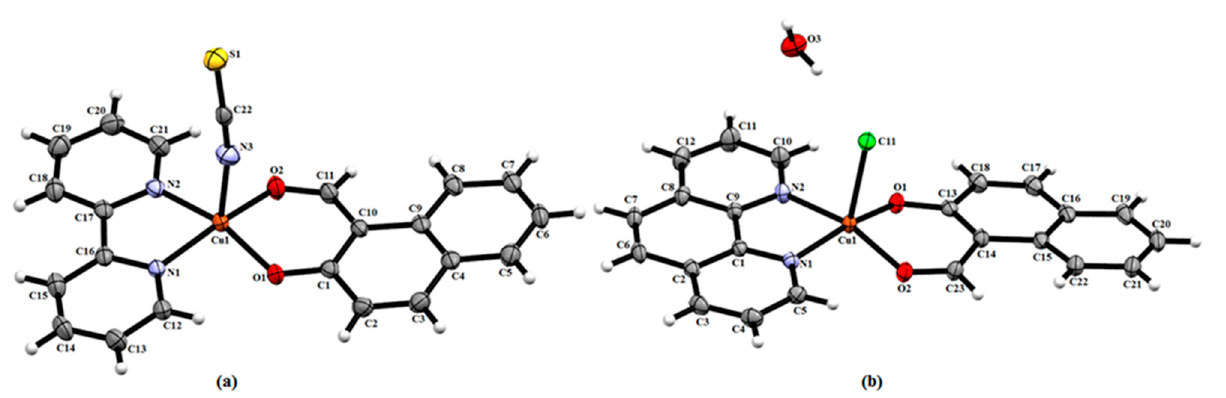
Figure 1. An ORTEP view of the asymmetric unit of the two complexes. ( a ) [Cu (C 11 H 7 O 2 )